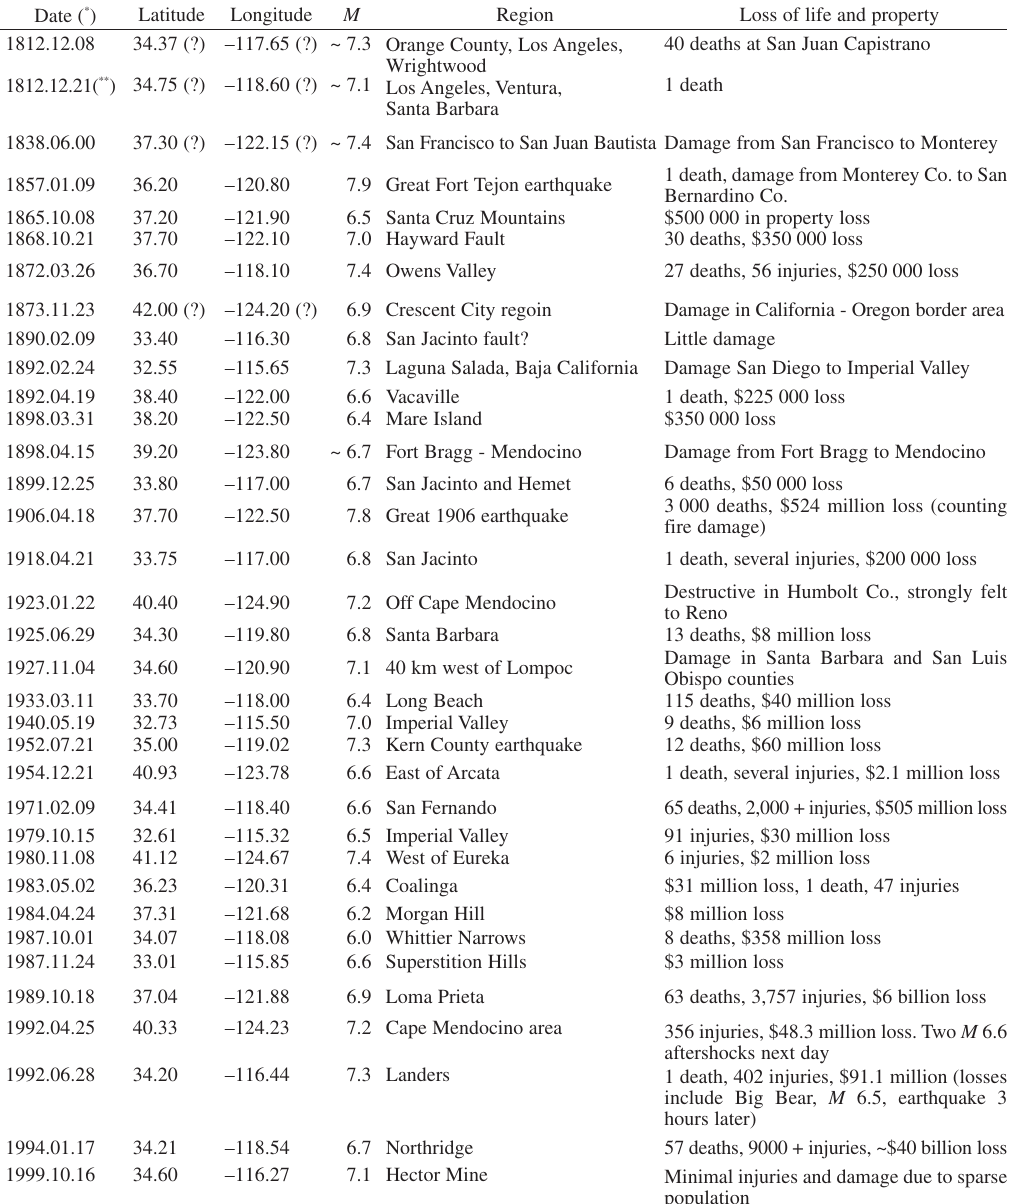
Table I. Significant California earthquakes ( M ~ 6 to 6.5 and/or